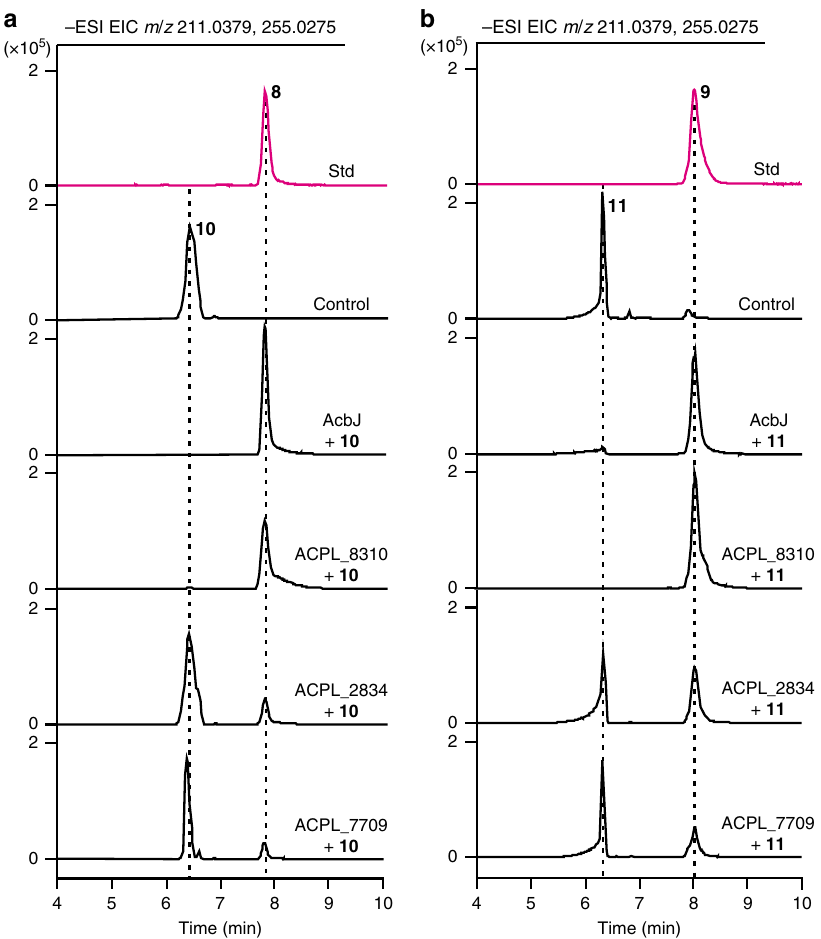
Fig. 3 Identi fi cation of hydrolases involved in the dephosphorylation of 10 and 11. a , b HPLC-TOF/MS analysis of the dephosphorylated products of 10 and 11 catalyzed by AcbJ, ACPL_8310, ACPL_2834, or ACPL_7709 in vitro, and the reaction without enzyme was set as a negative control. The standards (std) of 8 and 9 were also analyzed. All of the chromatograms show the simultaneous extraction of calculated ions m / z = 211.0379 [M + Cl] − for 8 and 9 and m / z = 255.0275 [M-H] − for 10 and 11 . Source data are provided as a Source Data fi